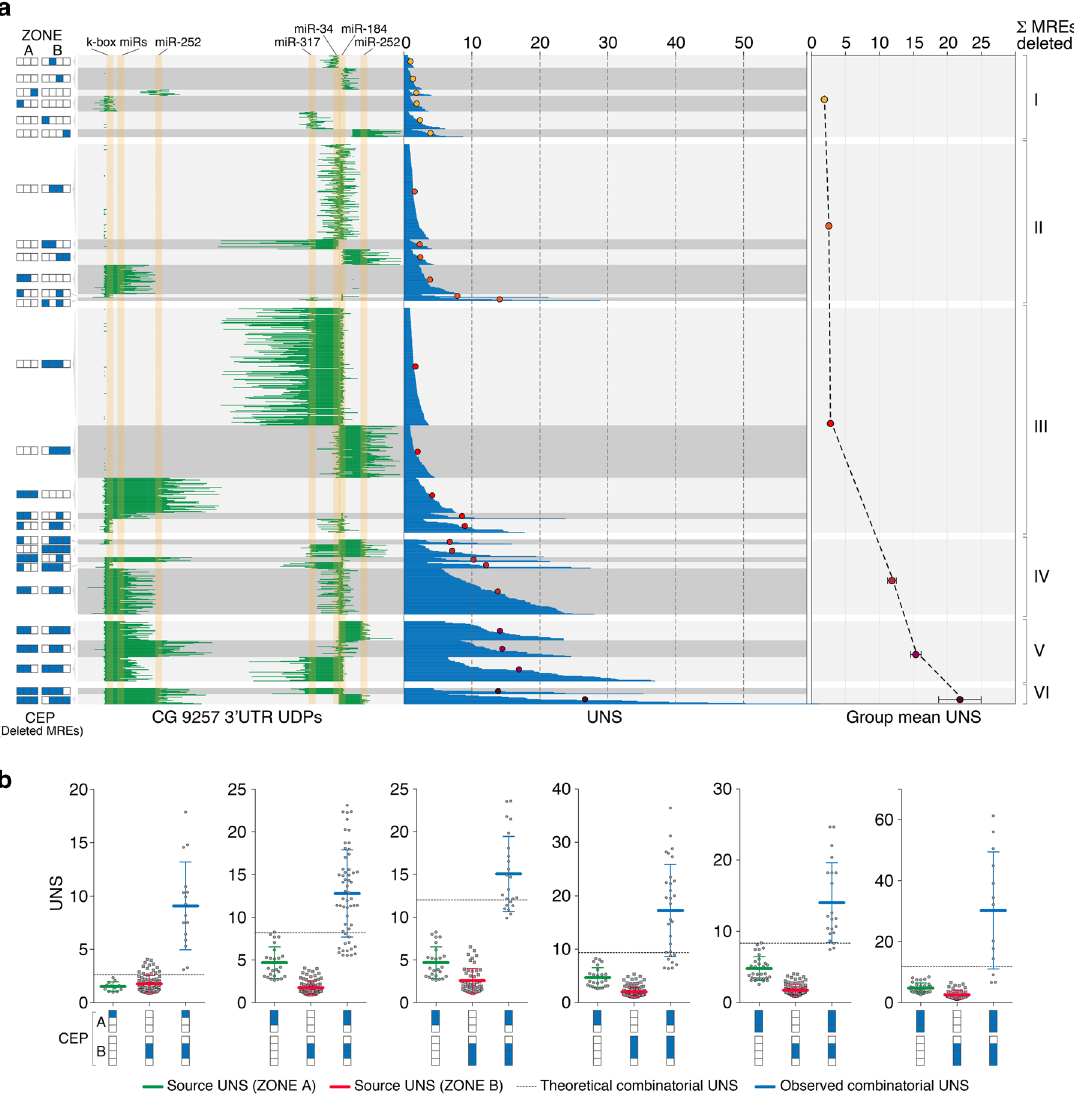
Fig. 5 Multiplex GenERA uncovers cooperative regulatory activities between putative MREs. a Summary of MRE combinatorial UDP analysis. The blue / white box code on the far left displays all combinatorial editing patterns (CEPs) that passed a minimum UDP count fi lter ( > 10 UDPs) and were included in the analysis ( blue = MRE deleted; white = MRE intact). Green lines re fl ect the identity of each UDP associated with a corresponding CEP. Yellow shaded areas indicate the position of the seven predicted MRE seed sequences. UNS values were calculated for each UDP ( blue histogram , fi rst to last quartiles) and used to derive an average UNS value for each CEP (coloured dots). All CEPs were fi nally clustered based on the number of total deleted MREs (1 – 6) and a mean UNS value was calculated for each group ( right panel, error bars = SEM). b Analysis of MRE cooperative activity. Scatter plots represent UNS values ( fi rst to last quartiles) of different Zone A ( green ) or Zone B ( red ) source CEPs, their corresponding theoretical combinatorial UNS ( dashed line ), and the observed combinatorial UNS ( blue ). Each individual datapoint represents an experimentally determined UNS value. In all cases analysed, the observed combinatorial UNSs are signi fi cantly higher than the predicted values suggesting the presence of cooperative interactions between Zone A and Zone B MREs (Error bars = +/ − SD, Mann-Whitney test, ****P <